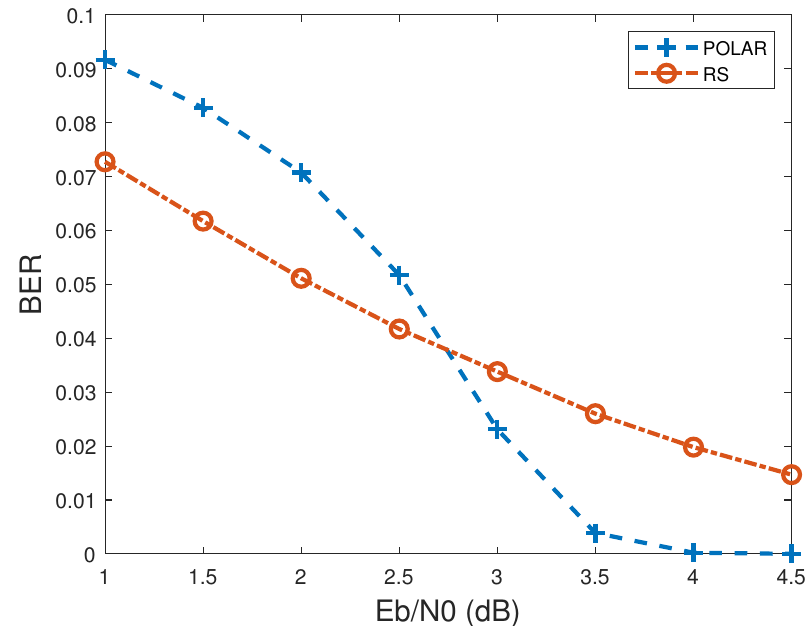
Figure 6. BER of different SNR values for RS and Polar